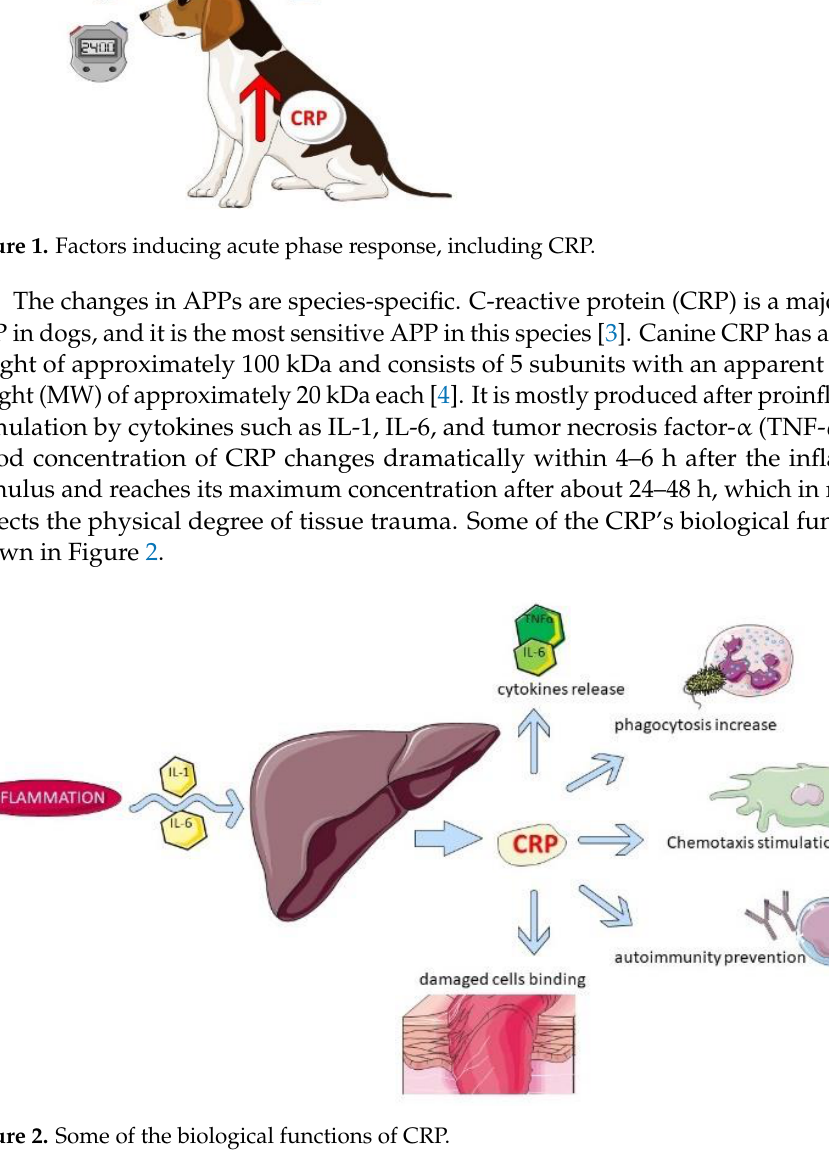
Figure 2. Some of the biological functions of CRP. An increase in CRP should not be considered a marker of etiologic diagnosis due to its low specificity. However, it is highly sensitive and has great diagnostic value in the presence of subclinical disease. CRP’s increase in several inflammatory or non-inflammatory condi- tions [6–12] is shown in Table 1. Thus, such an assay should be taken into consideration when deciding on early treatment and can guide the